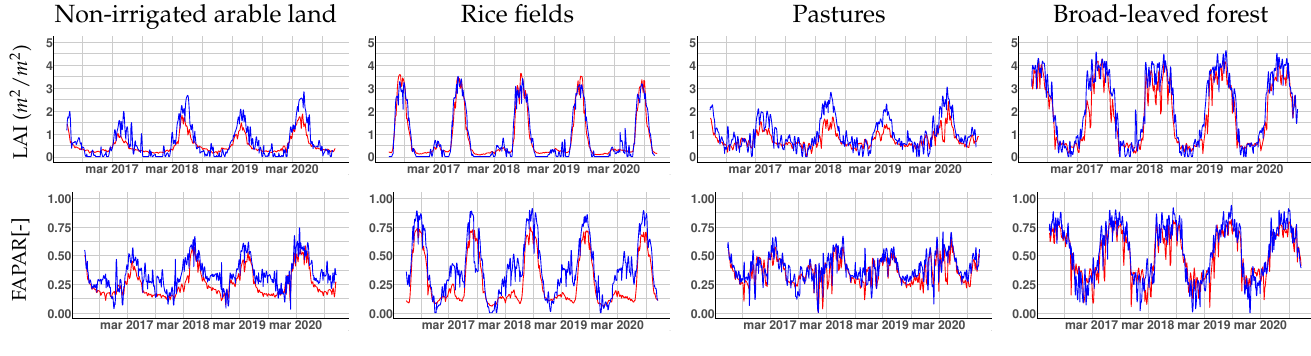
Figure 7. GPR method versus MODIS MCD15A3H product for LAI and FAPAR (rows) time series over following land covers: non-irrigated arable land, rice fields, pastures, and broad-leaved forests (columns). Original resolution of 300 m was used for spatial average calculations. Closest agreement between both products were found on rice fields for LAI, and on broad-leaved forests for FAPAR, with minimum percentage differences between MCD15A3H and S3 TOA-GPR time series averages ( ∆ X in last column of Table 4) of 6.59% (LAI) and 7.27% (FAPAR). Conversely, the maximum differences were found